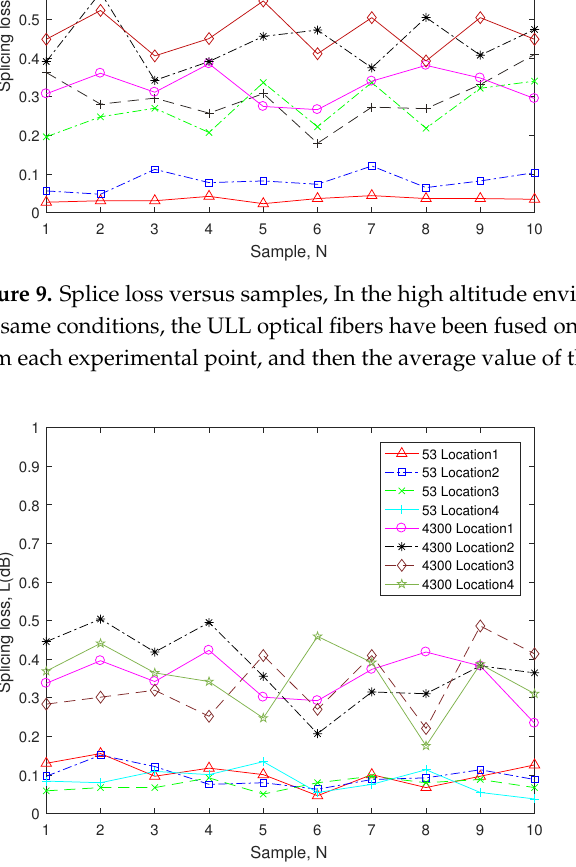
Figure 10. Splice loss versus samples, in four different locations with an altitude of 53 m (plain) and in four different locations with an altitude of 4300 m respectively, under the same conditions, the ULL optical fibers have been fused on site, and 10 samples have been taken from each experimental point, and then the average value of the results has been